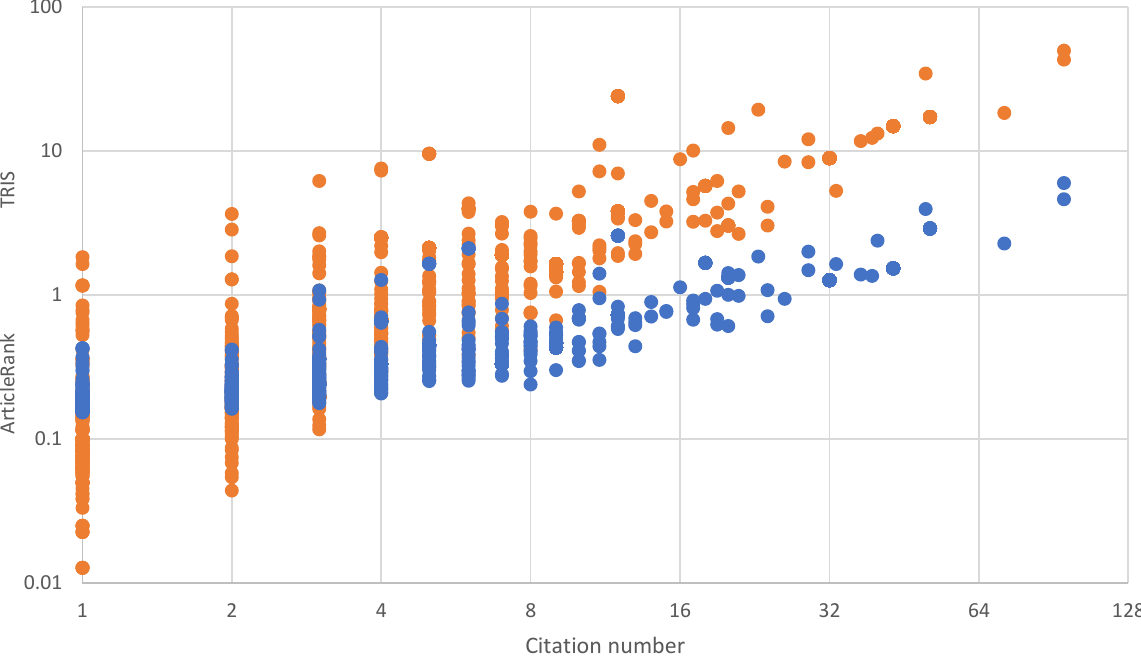
Figure 2. Comparison of measures obtained for all papers of the exemplary dataset.